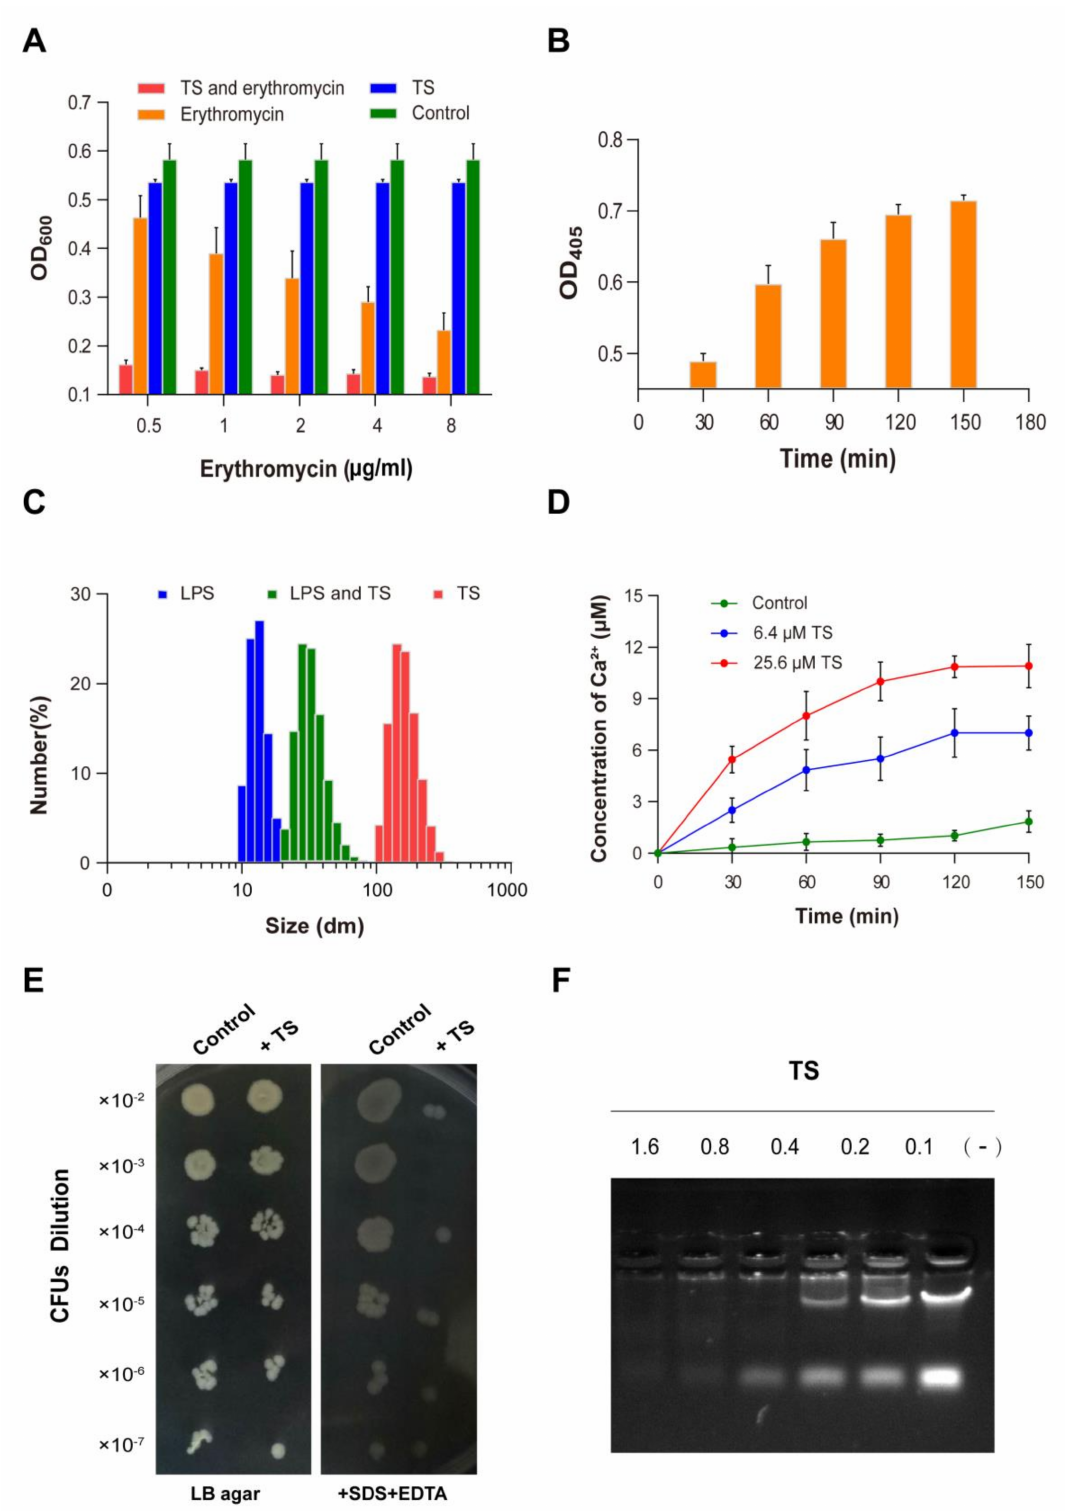
Figure 5. Antibacterial mechanism of antimicrobial peptide TS. ( A ) The effect of TS on permeabilizing the outer membrane of E. coli ATCC 25922. ( B ) The effect of TS on permeabilizing the inner membrane of E. coli ATCC 25922. ( C ) Interaction of antimicrobial peptide TS with lipopolysaccharides (LPSs). ( D ) Release of Ca 2+ and K + from TS-treated E. coli ATCC 25922. ( E ) The sensitivity of TS-treated E. coli ATCC 25922 to SDS/EDTA. ( F ) Gel retardation analysis for the binding of TS to the DNA of E. coli ATCC